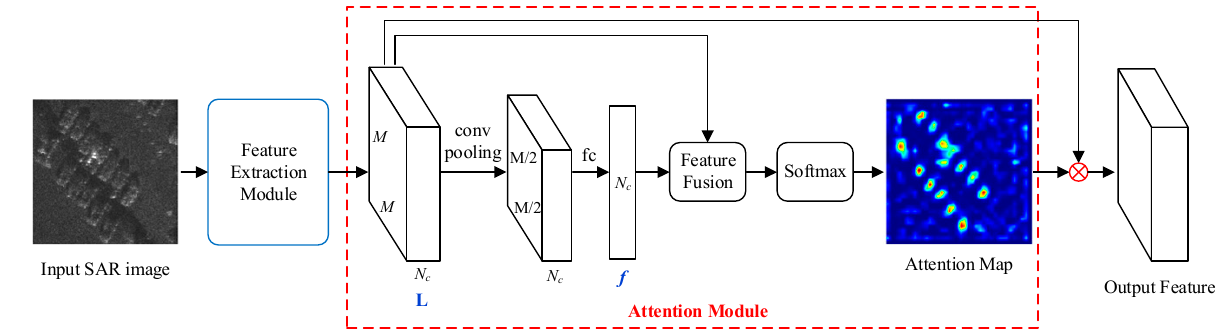
Figure 2. Flowchart of the attention module.